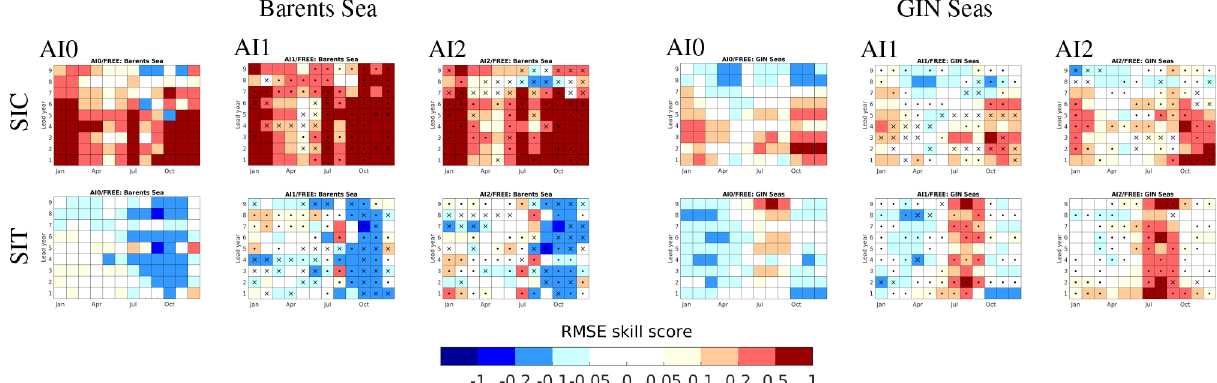
Figure 10. Regional Arctic SIC (upper) and SIT (lower) prediction in the Atlantic Arctic sector, i.e. Barents Sea (left) and GIN seas (right): RMSE skill score of AI0 / FREE, AI1 / FREE and AI2 / FREE, respectively. AI0 / FREE is calculated as 1 − ( RMSE AI0 / RMSE FREE ) , where the ratio of RMSE is averaged over regions. Scores above 0 denote more accurate in AI0 than FREE (red), and vice versa (blue). White colours denote a 0 score, which means RMSEs in AI0 (or AI1, AI2) and FREE are equal, respectively. Boxes for AI1 / FREE and AI2 / FREE are stippled by dots (or crosses) if the added skill is above 0.05 (or below − 0 . 05), which is the minimal colour interval of RMSESS. The added skill is calculated for AI1 as (AI1 / FREE − AI0 / FREE) and for AI2 as (AI2 / FREE − AI1 / FREE), respectively.